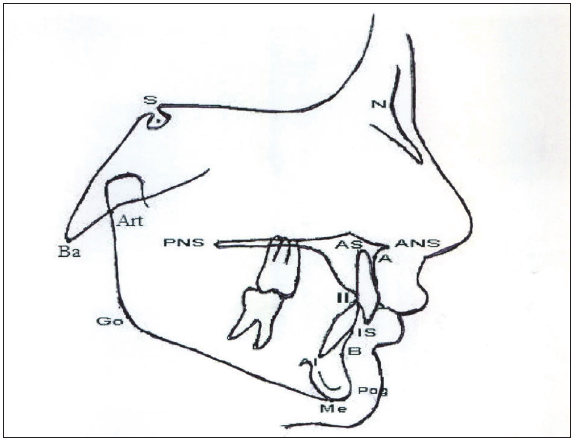
Figure 1. Cephalometric landmarks: S, Sella; N, Nasion; ANS, Anterior nasal spine; PNS, Posterior nasal spine; A, A point; IS, Incision superius; AS, Apicale superius; B, B point; II, Incision inferius; AI, Apicale inferius; Pog, Pogonion; Me, Menton; Go, Gonion; Art, Articulare; Ba, Basion.